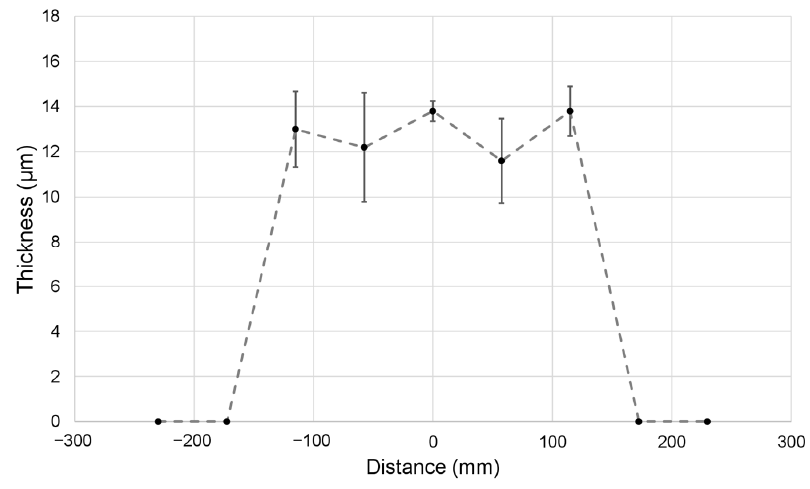
Figure 9. Thickness along the width of the membrane with parallel plate auxiliary electrodes, the dashed line is only a guide for the eyes.